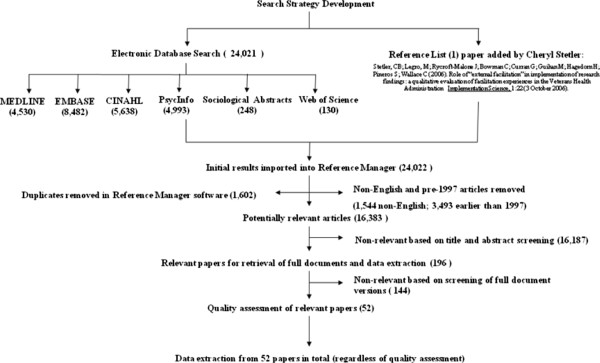
Screening process.